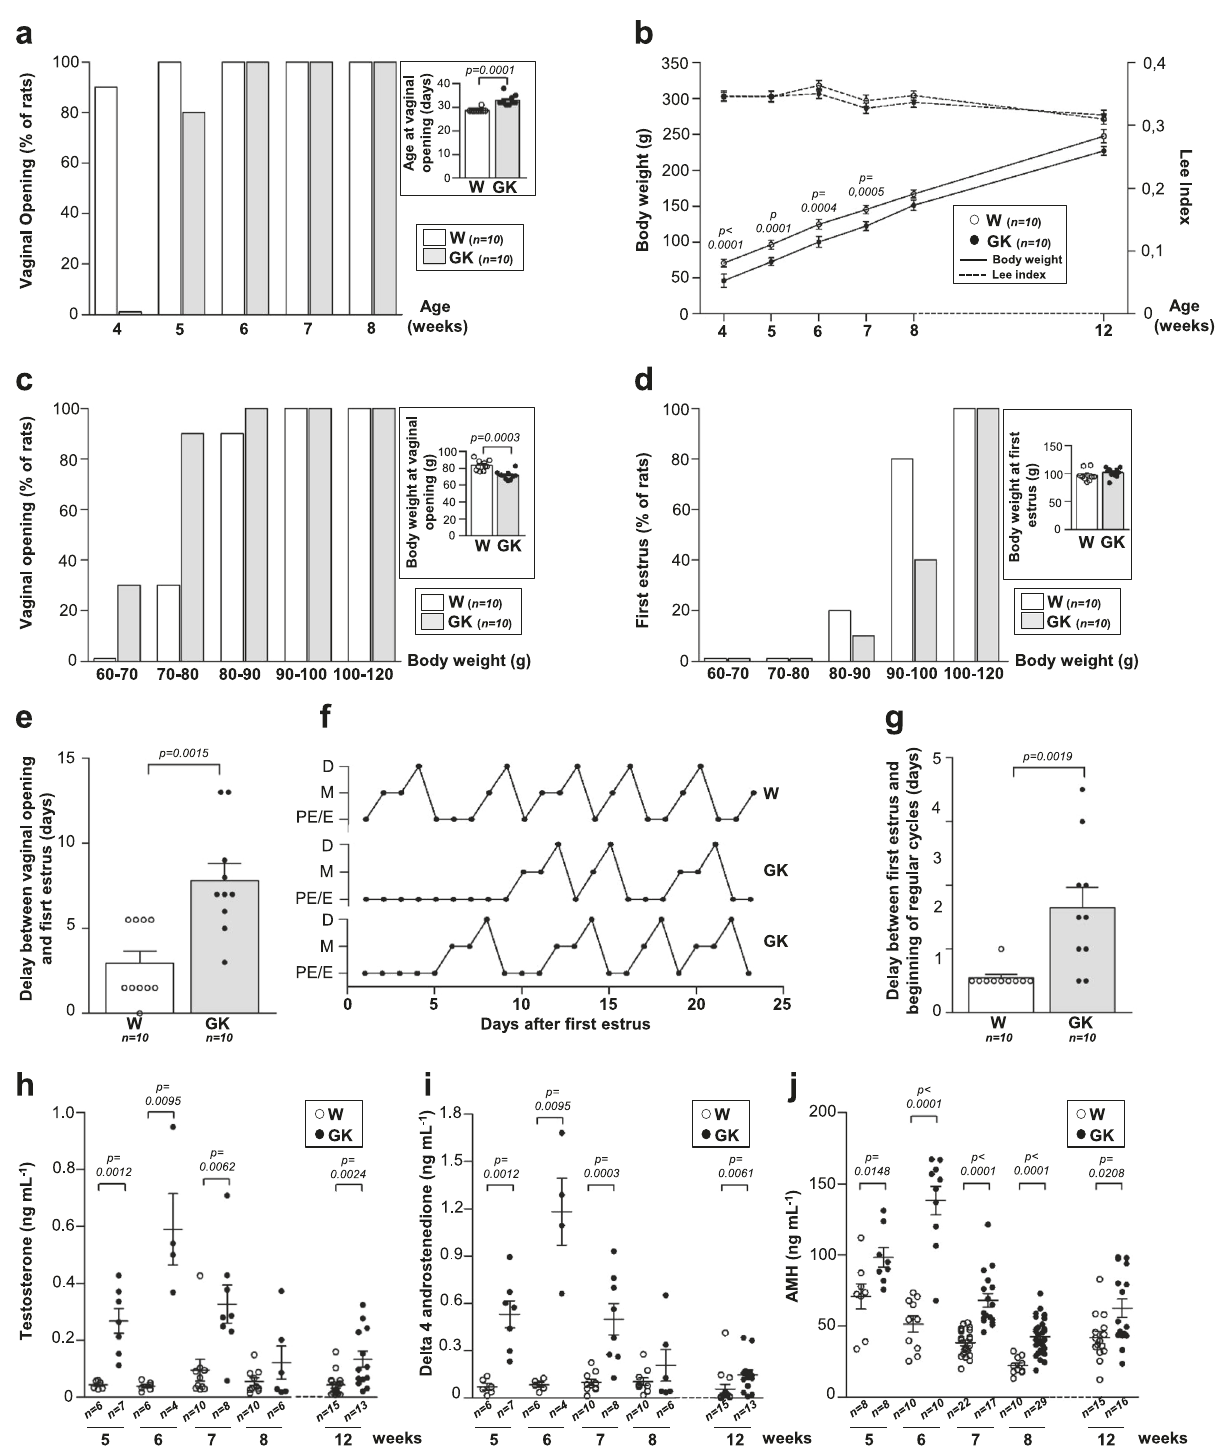
Fig. 5 Study of pubertal development of Wistar and GK rats. a Percentage of rats with opened vaginas from 4 to 8 weeks of age. Inset shows the mean age of the rats at the vaginal opening. b Evolution of body weight (full line) and of Lee index (dotted line) of Wistar and GK rats between 4 and 12 weeks. p - values are from two-sided Mann – Whitney U tests followed by a post-hoc Bonferroni ’ s adjustment. c Percentage of rats with vaginal opening in each body weight class. Inset shows the mean weight of rats at vaginal opening. d Percentage of rats at fi rst estrus for each body weight class. Inset shows the mean weight of rats at the time of the fi rst estrus. e Delay between vaginal opening and the fi rst estrus. f Illustration of estrous cycle pro fi les from the fi rst estrus for 1 Wistar and 2 GK rats. Proestrus – Estrus P – E, Metestrus M, Diestrus D. g Delay between fi rst estrus and the beginning of regular estrous cycles in Wistar and GK rats. h – j Serum levels of Testosterone ( h ), Delta-4-androstenedione ( i ), and AMH ( j ) assessed on 5 – 12-week-old Wistar and GK rats. Data are represented as box with scatter blot with mean ± SEM ( a , c , d insets and e , g ), as mean ± SEM ( b ) or as scatter blot with mean ± SEM ( h – j ). p -values are from two-sided Mann – Whitney U test for unpaired comparisons (GK vs. Wistar rats). n represents the number of biologically independent animals in each group. Wistar: white, GK: gray. Source data are provided as a Source Data fi le.